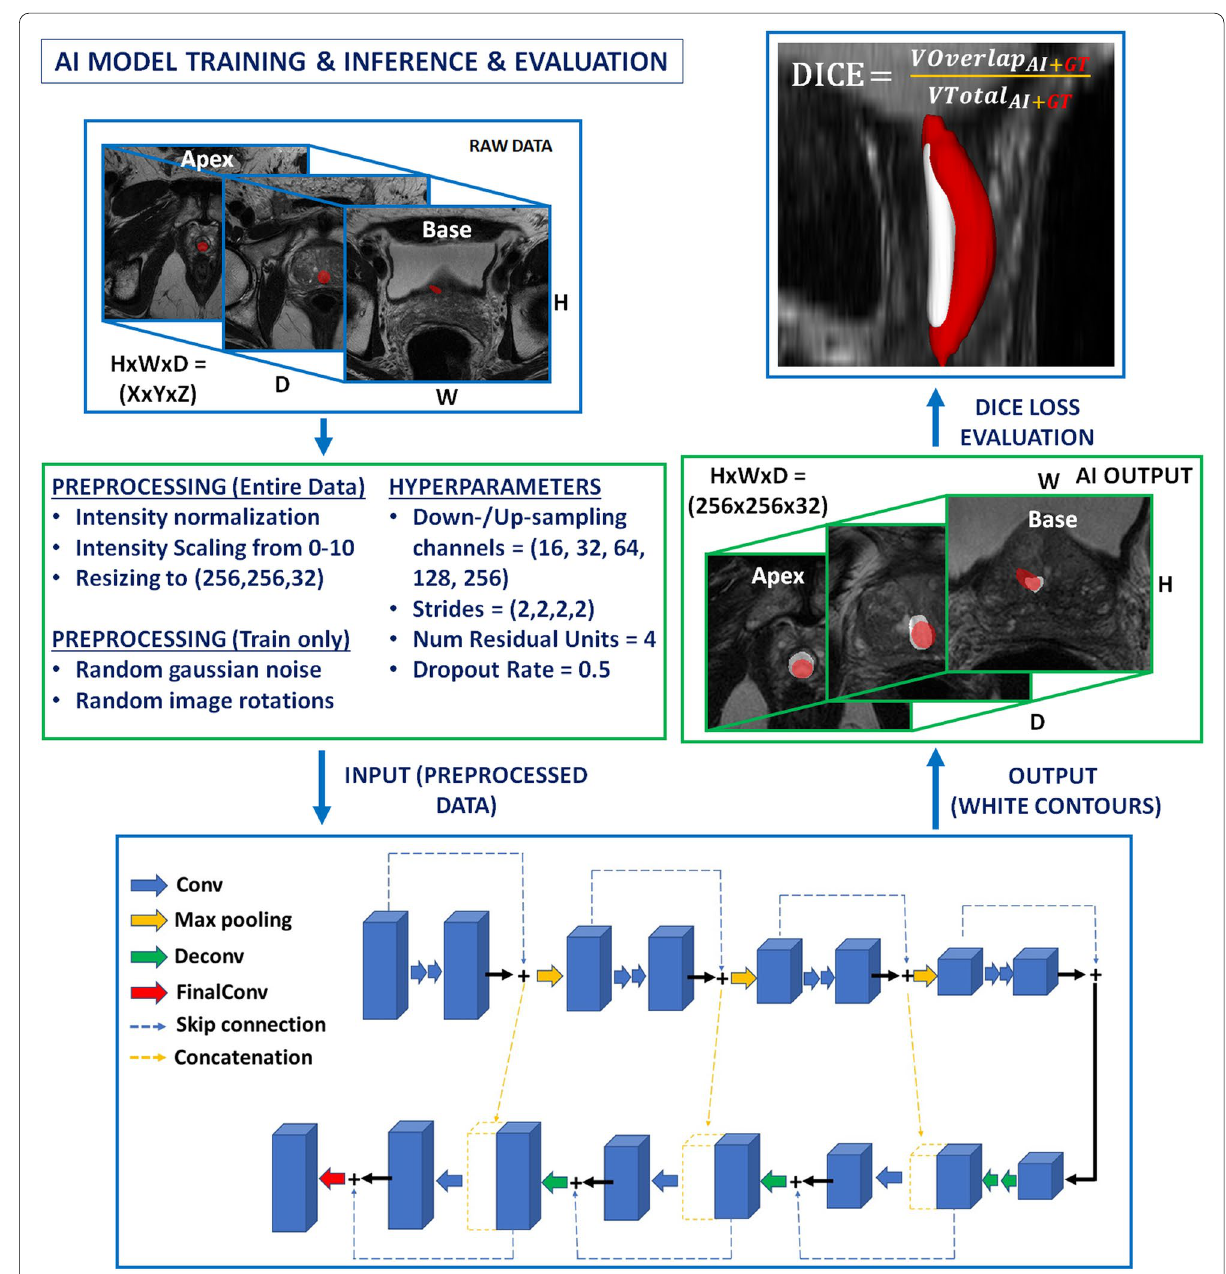
Fig. 3 Typical training/inference/evaluation workflow of segmentation AI showing a three-dimensional CNN U-Net for automated segmentation of the prostatic urethra. First, the raw T2-weighted image undergoes preprocessing for intensity normalization, size scaling/cropping, and for training the image undergoes additional data augmentations. Second, the preprocessed image is fed into the CNN which outputs the prediction or white segmentation. Third, the ground truth red urethral contour is compared to the AI-predicted white contour, the loss or difference is computed, and this loss is communicated back to the CNN for tuning of neuronal weights. At the final stage, the performance evaluation of the AI model is conducted using the Dice similarity coefficient. AI Artificial intelligence, CNN Convolutional neural